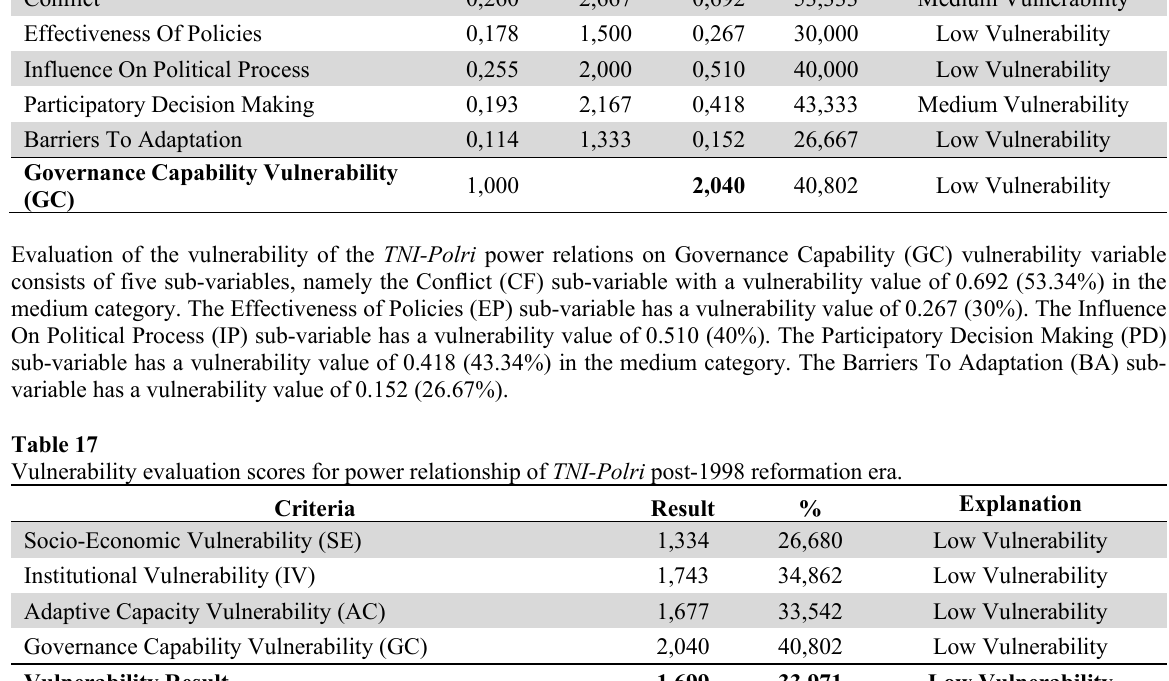
Based on Fig. 5 and Table 17, the evaluation of the vulnerability of the TNI-Polri power relations post-1998 Reform consists of four main variables. The socioeconomic (SE) variable has a vulnerability value of 1.334 (26.68%) in the Low Vulnerability category. The institutional (IV) variable has a vulnerability value of 1.743 (34.86%) in the Low Vulnerability category. The Adaptive Capacity (AC) variable has a vulnerability value of 1,677 (33.542%) in the Low Vulnerability category. The Governance Capability (GC) variable has a vulnerability value of 2,040 (40.80%) in the Low